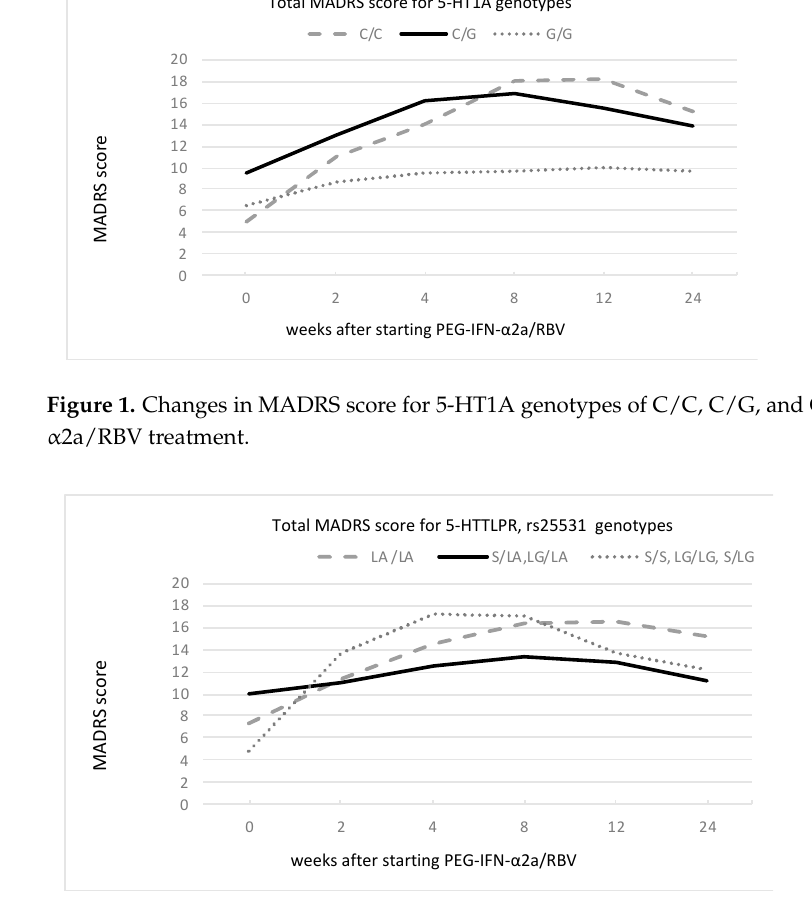
Figure 2. Changes in MADRS score for functional 5-HTTPLR genotype groups of L A /L A ; S/L A and L G /L A ; and S/S, L G /L G , and S/L G during PEG-IFN- α 2a/RBV treatment.